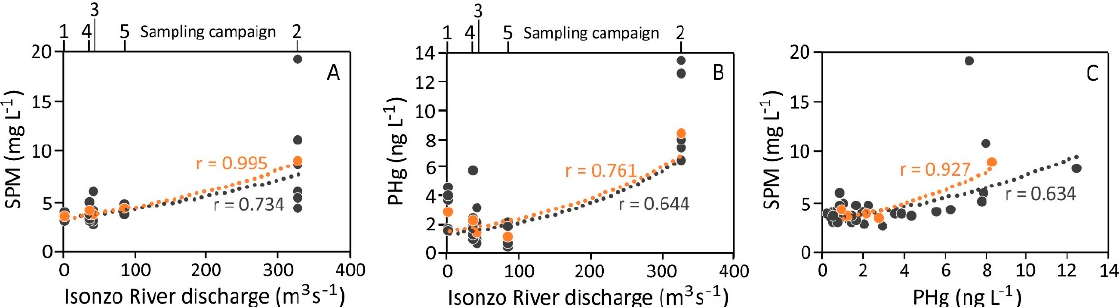
Figure 5. Correlation between the Isonzo River discharge (m 3 s − 1 ) and ( A ) SPM concentration (mg L − 1 ), ( B ) PHg concentration (ng L − 1 ) and ( C ) between the SPM concentration (mg L − 1 ) and PHg concentration (ng L − 1 ) in the surface water layer at the six investigated sites in the Bay of Panzano. Average SPM and PHg values and correlations are plotted in orange. Best fit was obtained using a 2nd-order polynomial curve.